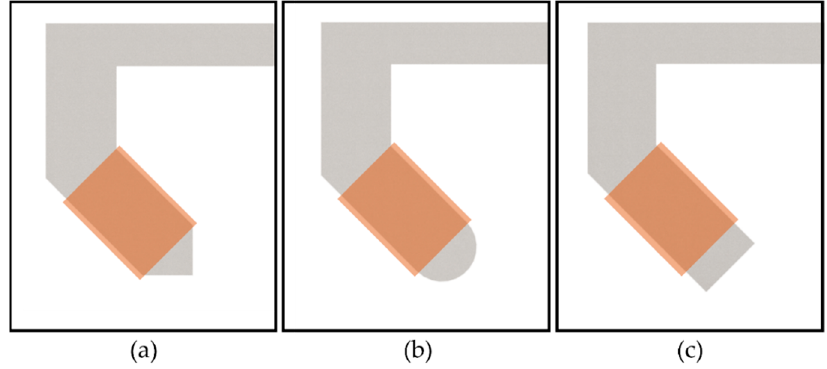
Figure 4. Various core tips for the C-Mag. ( a ) Arrow tip. ( b ) Round tip. ( c ) Square tip.